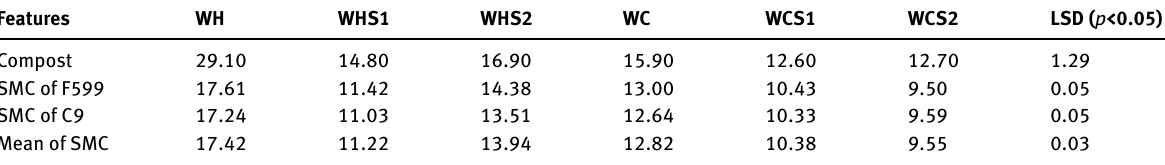
Table 5: Carbon:Nitrogen (C:N) ratio of composts